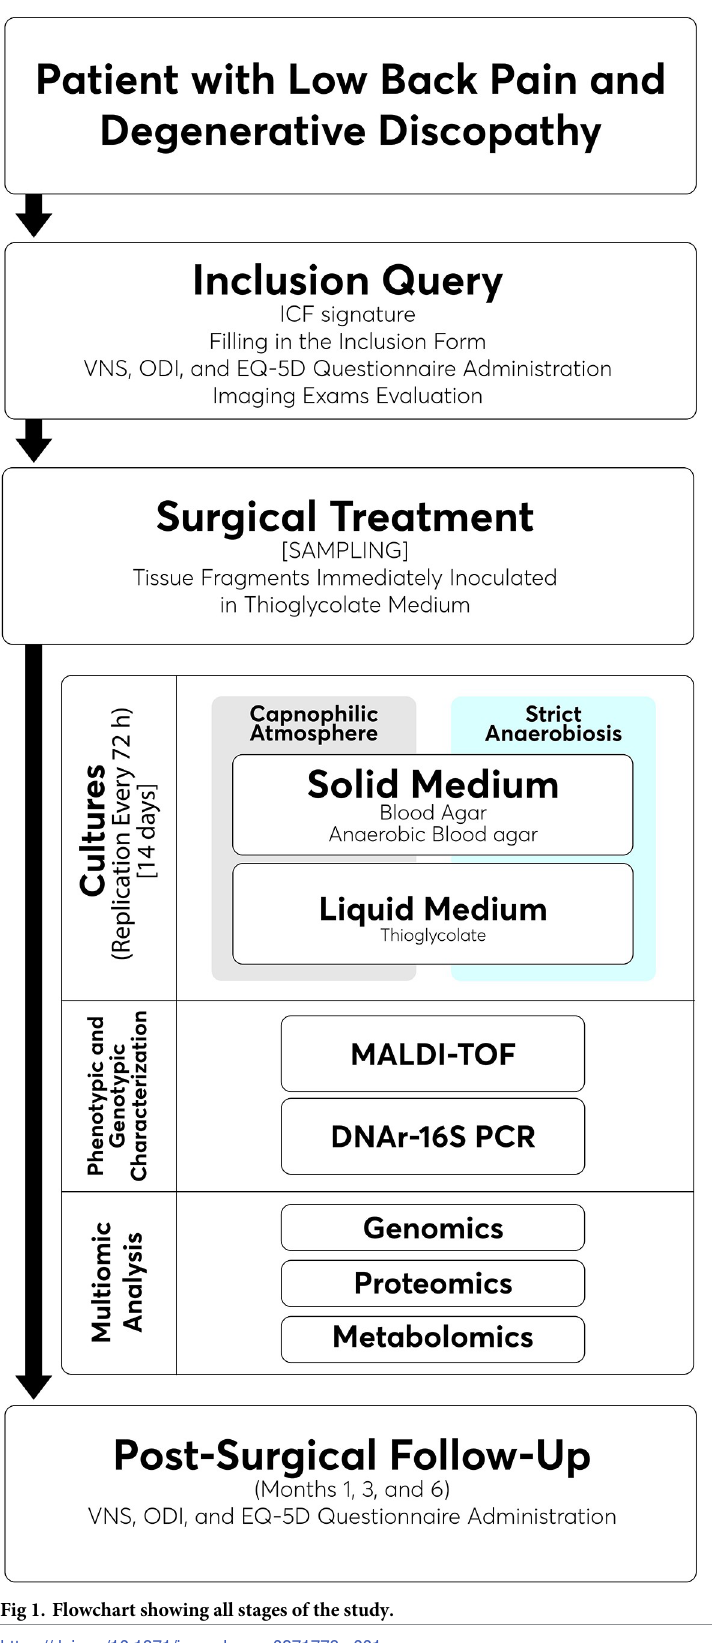
Fig 1. Flowchart showing all stages of the study.